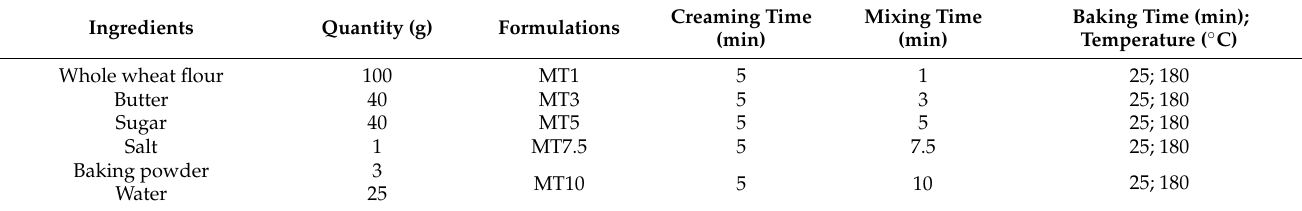
Table 1. Composition of cookie and parameters of